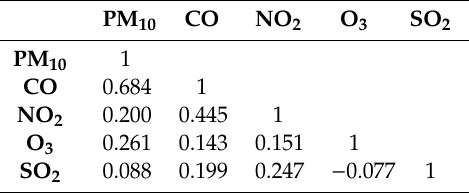
Table 2. Correlation among the pollutant